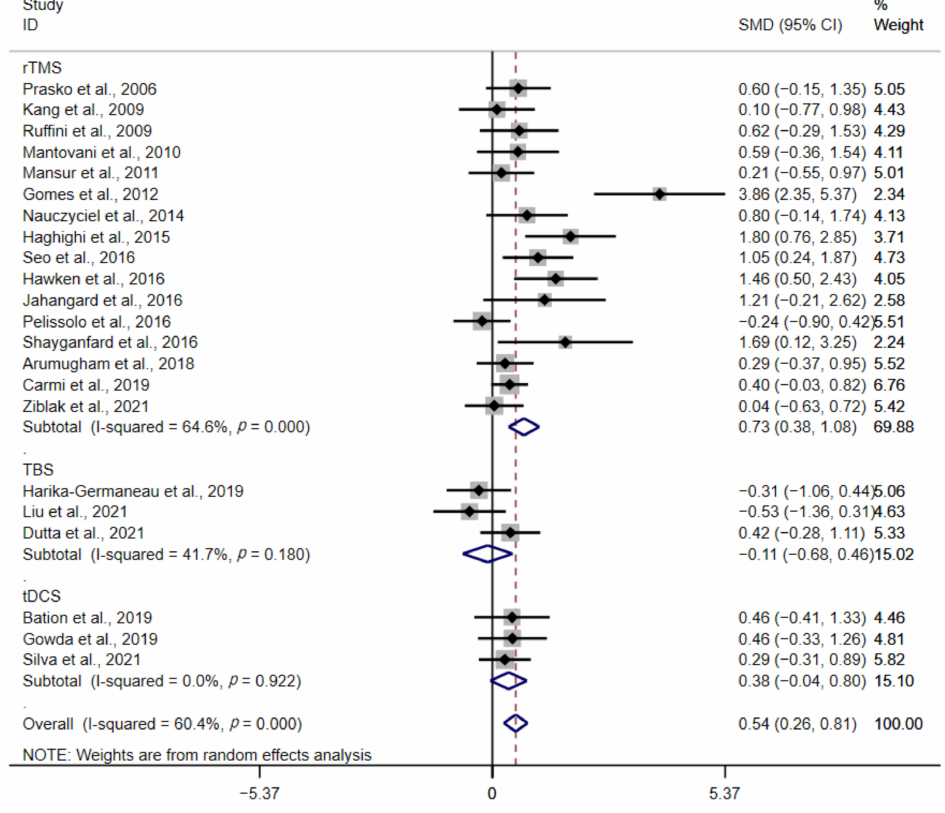
Figure 4. Forest plot of different stimulation types